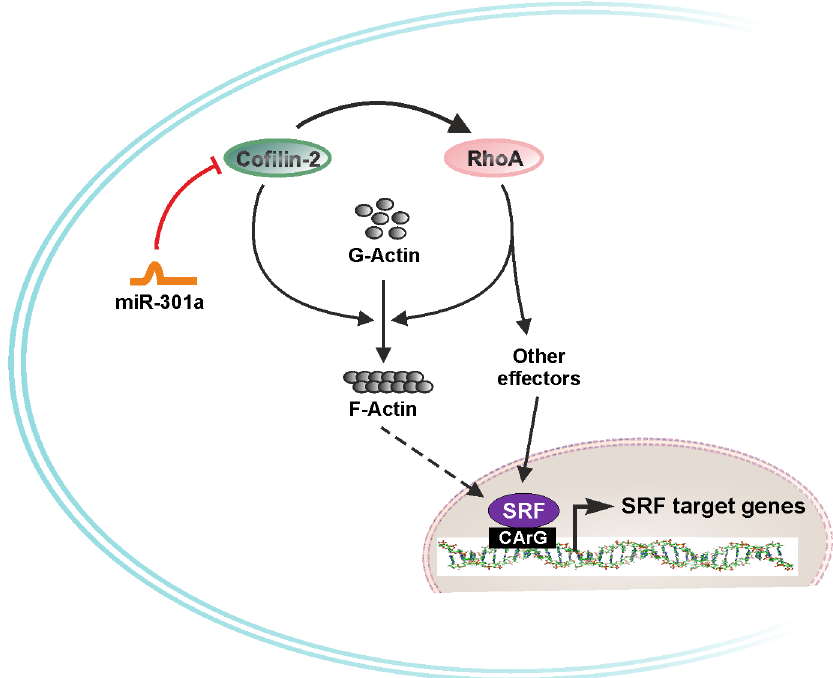
Fig 7. Model figure of cardiac role of Cfl2 and miR-301a. Our data from the present study illustrated involvement of Cfl2 in the activationof SRF signalingvia RhoA. Both RhoA and Cfl2 plays important role in actin treadmilling.Increasedlevels of F-actin in turn activates SRF signaling.RhoA also activates SRF signaling through other effector moleculeslike myocardin-related transcription factors, etc.. On the